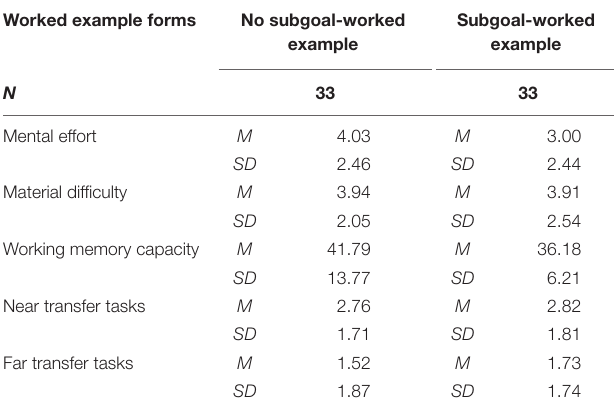
TABLE 1 | Participants’ cognitive load level, working memory capacity and transfer scores in different example